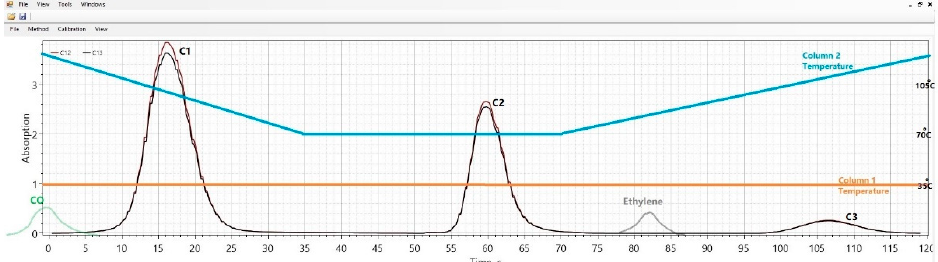
Figure 3. Typical GC–IR 2 isotope ratio chromatograph of C1 through C3, separated and analyzed in 120 s. The C1 through C3 chromatograph each have two traces (dark red for 12C and black for 13C). Carbon monoxide (CO) and ethylene, if present, are indicated by the green peak before C1 for CO, and the gray peak in between C2 and C3 at 78–88 s. Original concentrations of the natural gas sample are 96%, 2.9% and 0.48% for methane, ethane and propane, respectively, and samples are diluted separately to give the optimal readings of isotope values for all three species. Temperature ramps for the two columns are given in brown and light blue colors, and temperature values are given on the right vertical